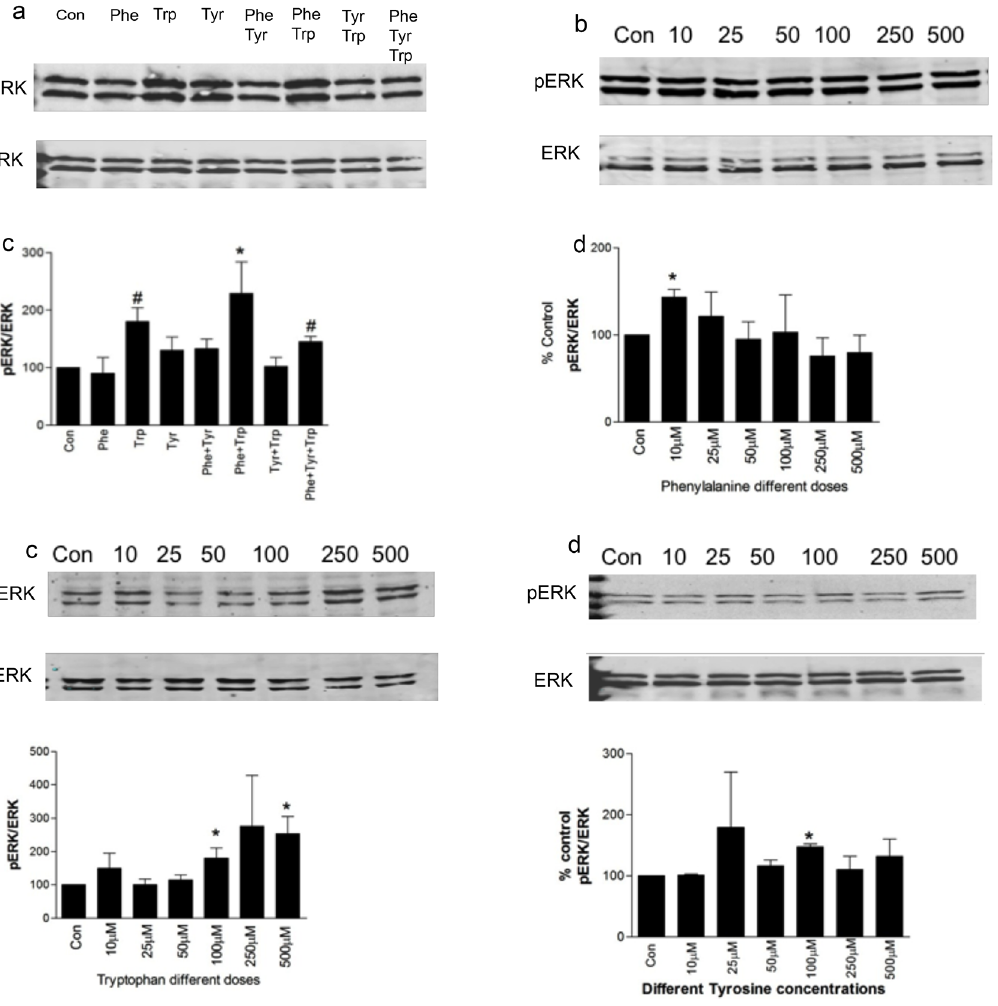
Figure 5. Effect of aromatic amino acids on the MAPK pathways. Western blot graphs of BMMSCs grown under normoxic conditions (21% O 2 /5% CO 2 ). When cells were 80% confluent, they were treated with either Phe, Tyr or Trp alone and in combinations (100 m M) in serum-free media and compared to the untreated BMMSCs (control=100%). The cells were washed twice with PBS and lysis buffer was added to the plates. Results are expressed as means 6 SEM for at least three independent experiments. * p # 0.05 and # p # 0.01. a- Different aromatic amino acids singly or in combinations as indicated (100 m M). b- Phe different doses (0–500 m M). c- Trp different doses (0–500 m M). d- Tyr different doses (0–500 m